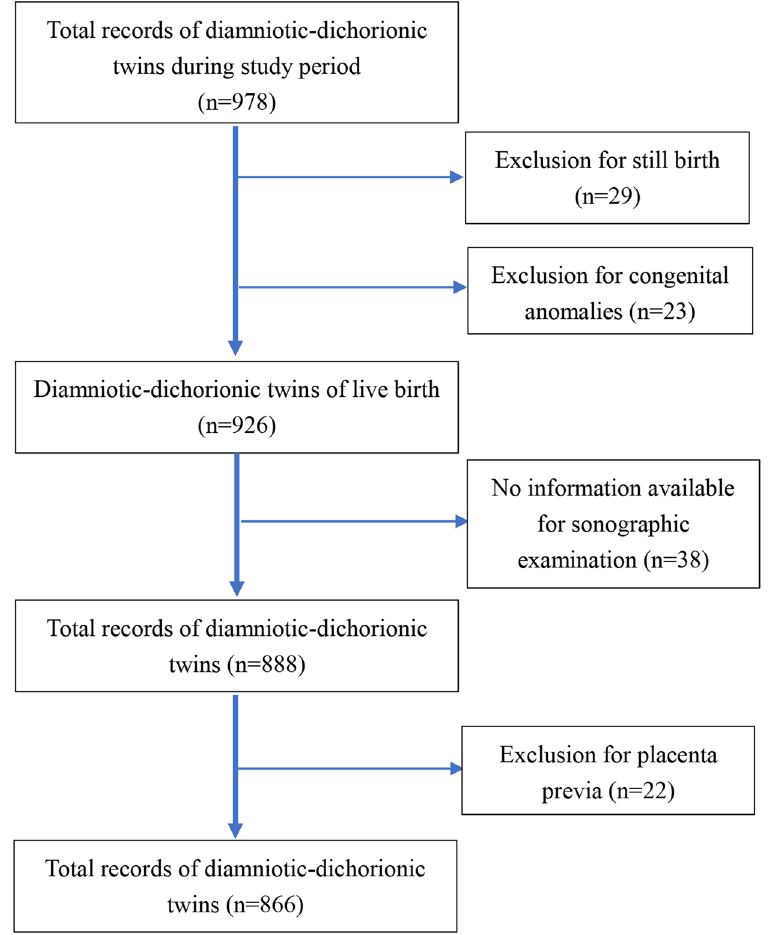
Figure 1. Flowchart of selection of eligible